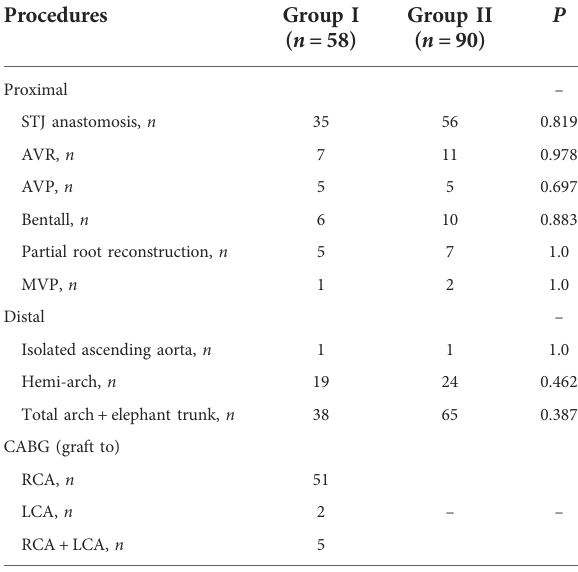
TABLE 2 Details of the proximal and distal aortic repair.